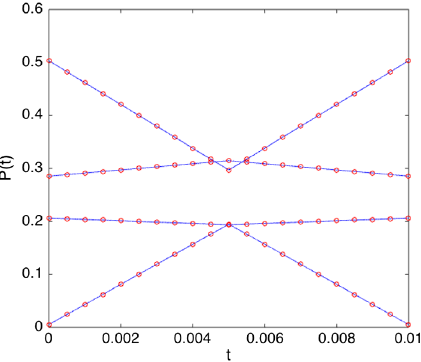
FIG. 4. ~p ð t Þ of the proposed construction for our four-state example. The blue line is the exact (constructed) solution, and the red dots represent the numerical solution of the master